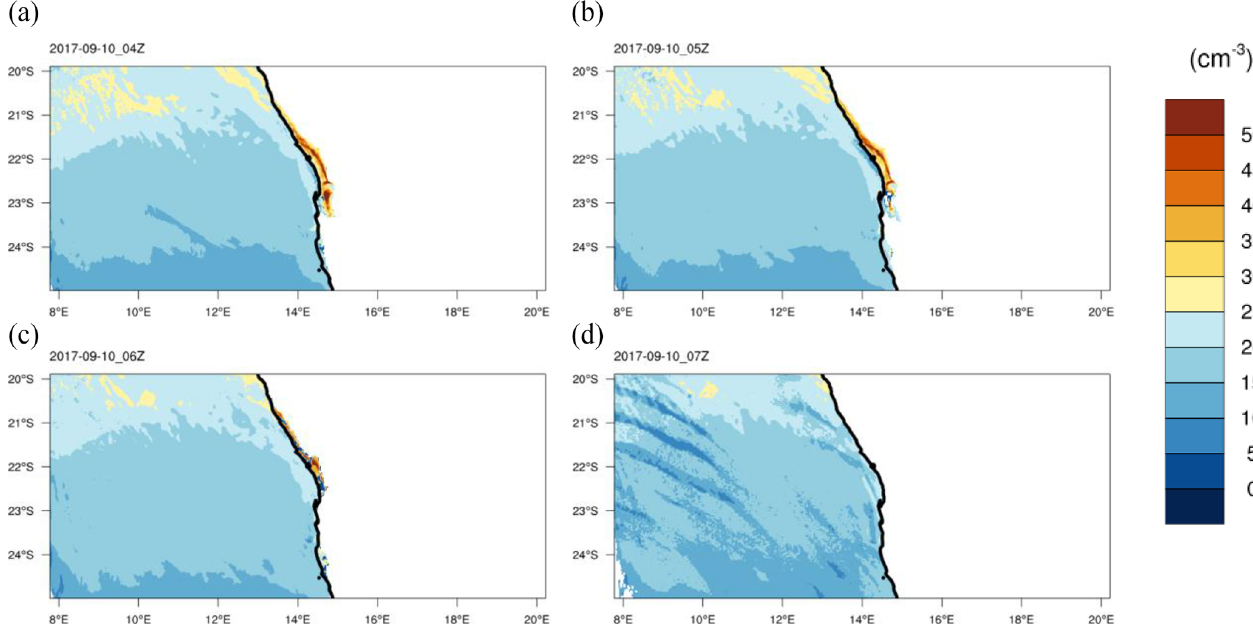
Figure 13. Cloud droplet concentration (cm − 3 ) during maximum extent and highest concentration for the event on 10 September 2017 for scenario CCN_300. Maximum extent was at (a) 04:00UTC and maximum concentration at Henties Bay was at (d) 07:00UTC. The black dot is Henties